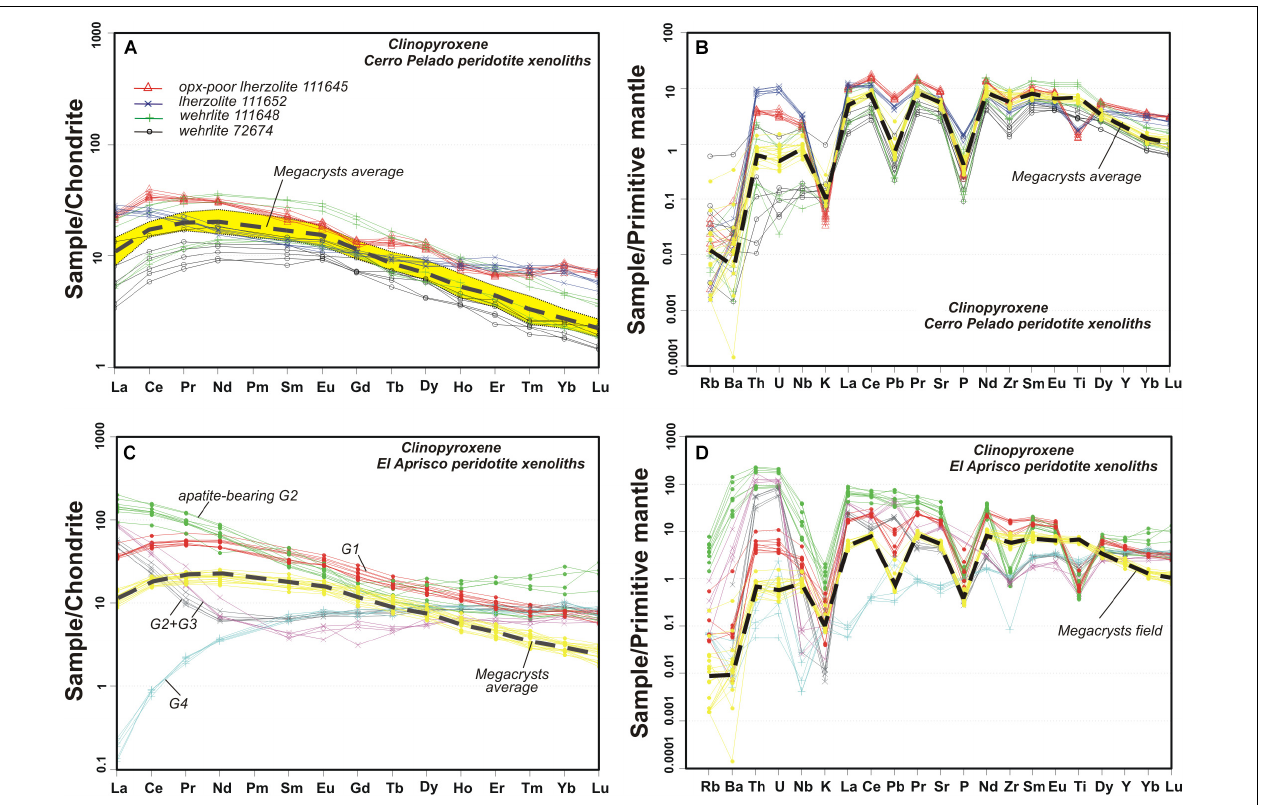
FIGURE 10 | Chondrite-normalized REE and primitive mantle-normalized trace element patterns of clinopyroxene of peridotite xenoliths from studied volcanic centers. Clinopyroxene trace element compositions of mantle xenoliths from the Cerro Pelado scoria cone are authors’ unpublished data (A,B) . Those (G1 to G4 groups) from the El Aprisco maar (C,D) are taken from Villaseca et al. (2010, 2019b) and González-Jiménez et al. (2014). The clinopyroxene megacryst average composition (discontinuous line within yellow field) from Figure 6 is shown for comparison. Chondrite and primitive mantle values are from Boynton (1985) and Sun and McDonough (1989),